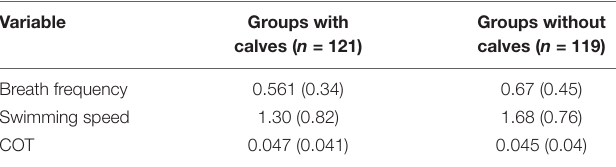
TABLE 4 | Median (Interquartile range) values for groups with and without calves of humpback whales. n = number of observations. Variable Groups with calves ( n = 121)